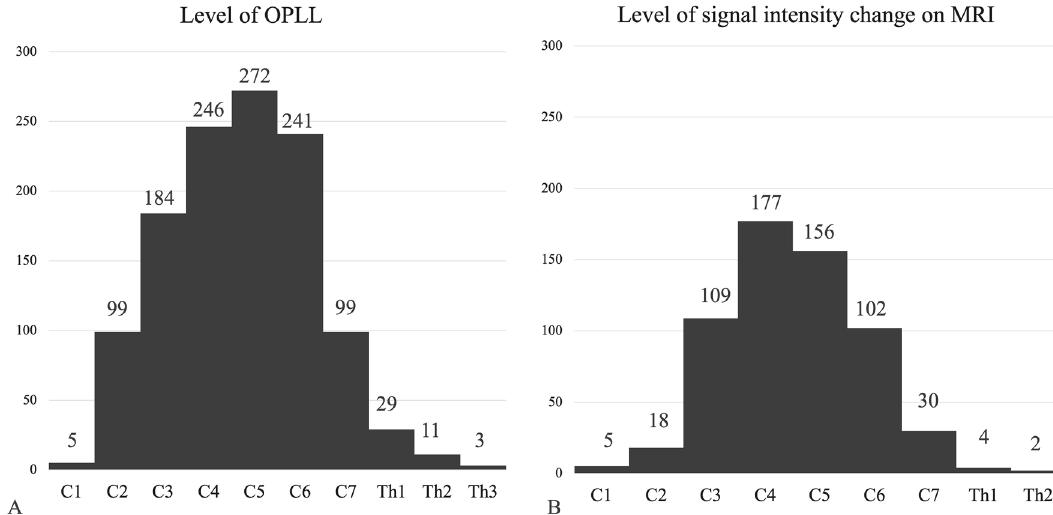
Figure 1. OPLL levels ( A ) and signal intensity changes on MRI ( B ). OPLL, ossification of the posterior longitudinal ligament; MRI, magnetic resonance imaging.